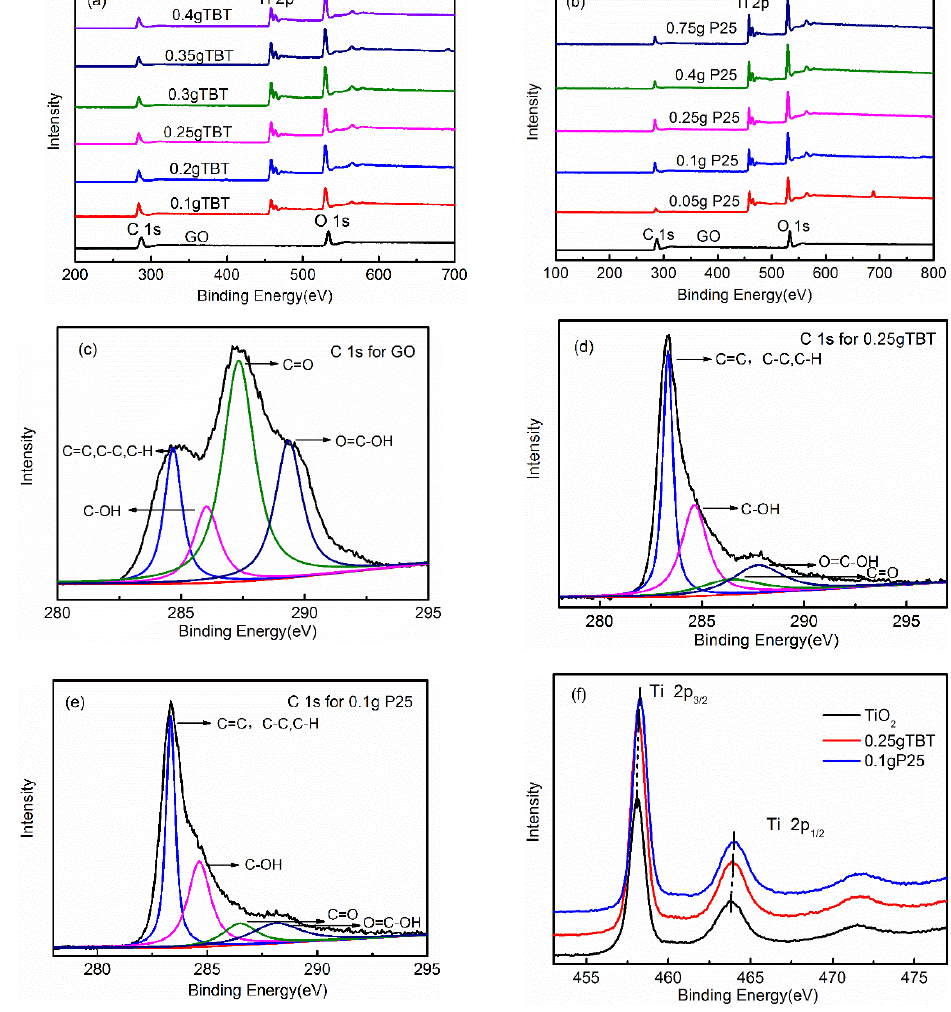
Figure 2. ( a ) X-ray photoelectron spectroscopy (XPS) spectra of GO, 0.1 g TBT, 0.2 g TBT, 0.25 g TBT, 0.3 g TBT, 0.35 g TBT, and 0.4 g TBT. ( b ) XPS spectra of GO, 0.05 g P25, 0.1 g P25, 0.25 g P25, 0.4 g P25, and 0.75 g P25. C 1s core-level spectra for ( c ) GO, ( d ) 0.25 g TBT, ( e ) 0.05 g P25, and ( f ) Ti 2p core.